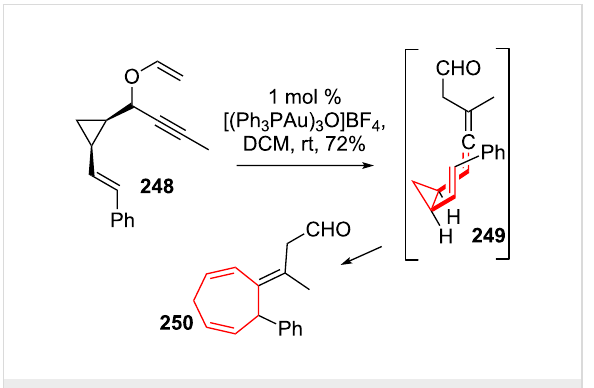
Scheme 32: Toste’s tandem gold-catalyzed Claisen-rearrangement/